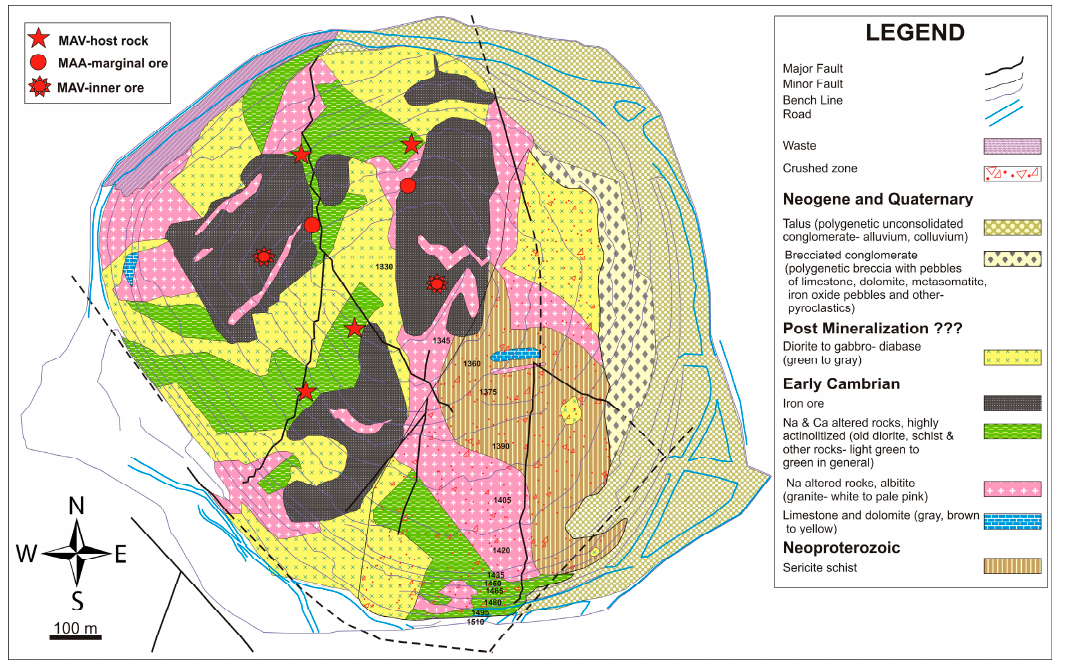
Figure 4. Geological map of the Chadormalu deposit [47] showing the locations of the samples representing the three main apatite types selected for this study.